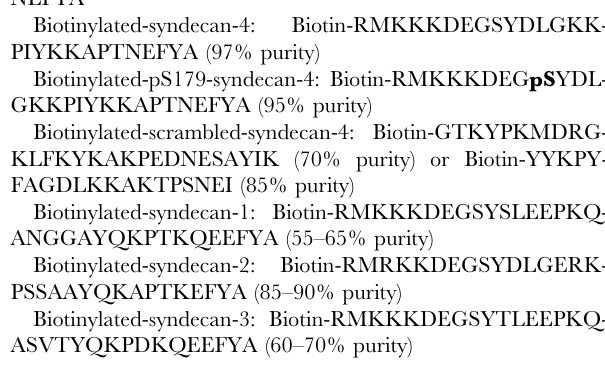
Figure S2 Activation of nuclear factor of activated